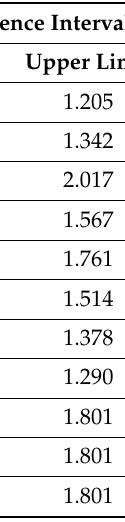
Figure 1. Summary of frequency analysis results for causes of successful escape in large cat prey.